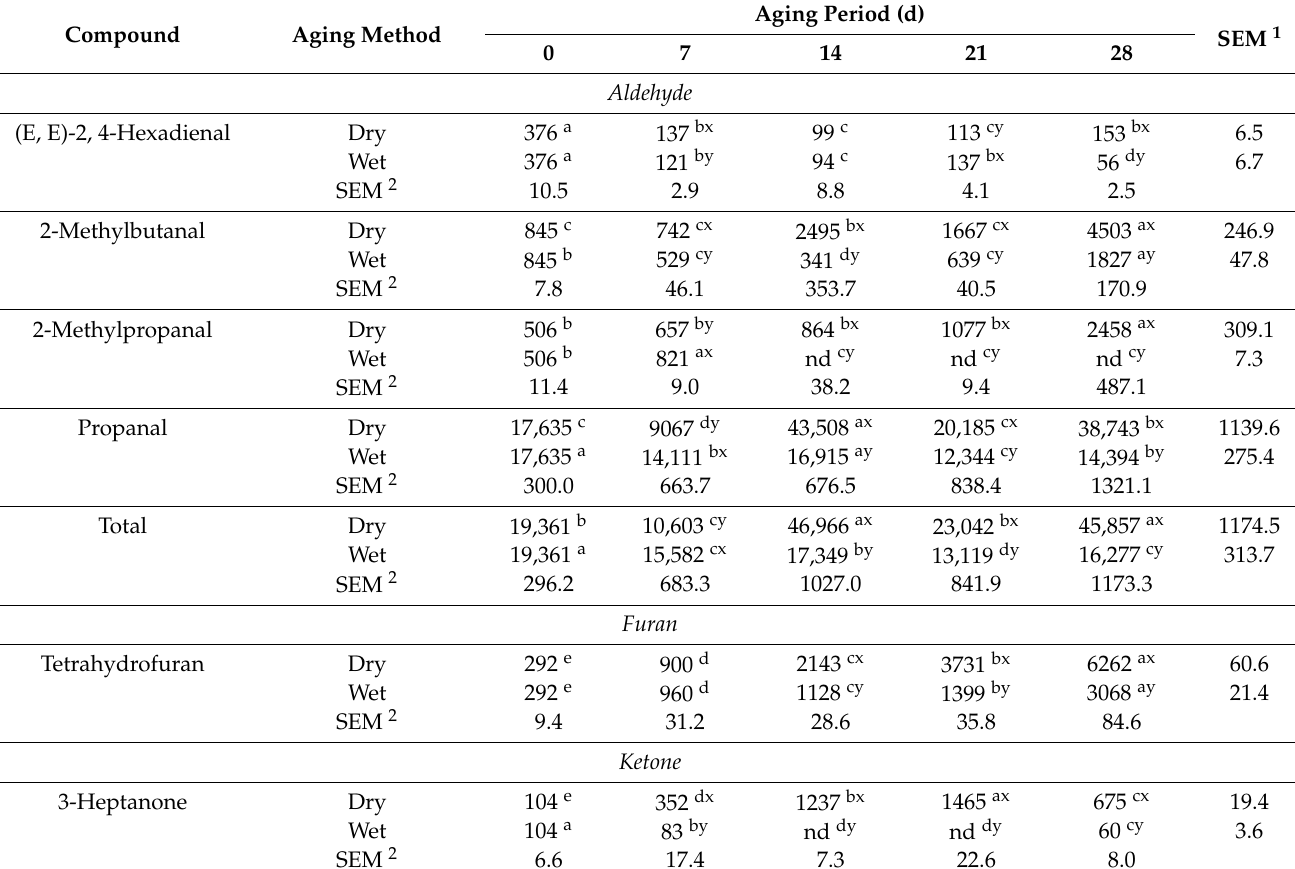
Table 3. Peak area of aldehydes, furans, and ketones in beef during aging with different aging methods. Compound Aging Method